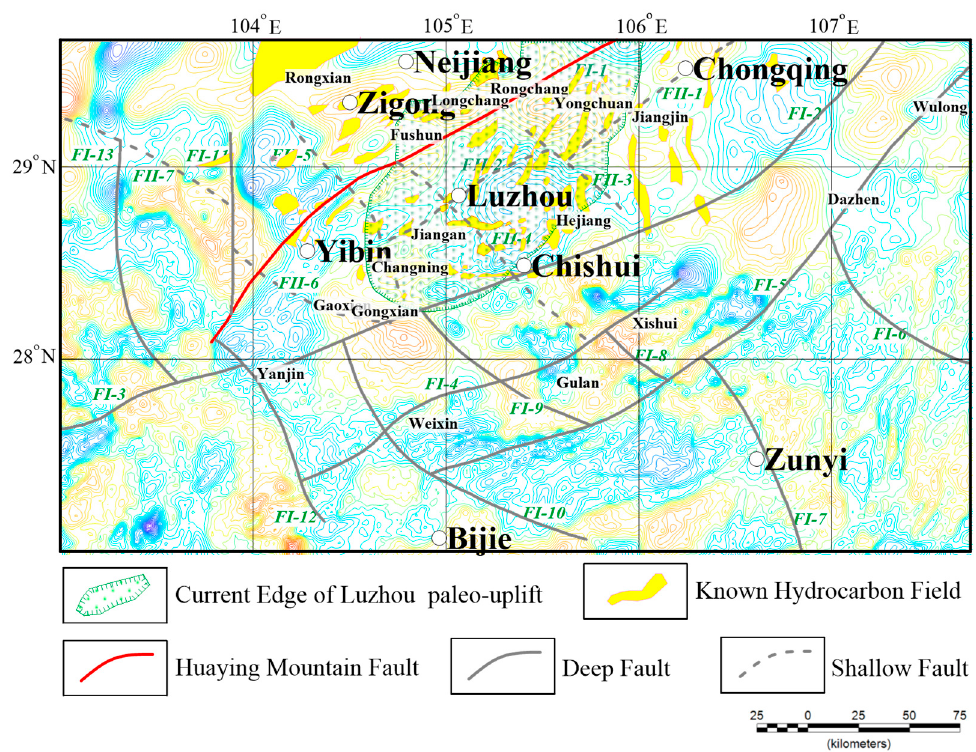
Figure 13. Location of present boundary range and known oil and gas fields of Luzhou paleo uplift (the background image is the residual isostasy anomaly).